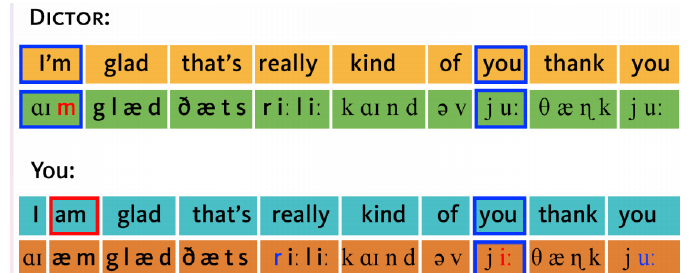
Figure 5. A prototype of user interface to show phonemic distortions in task 25 lesson 1.